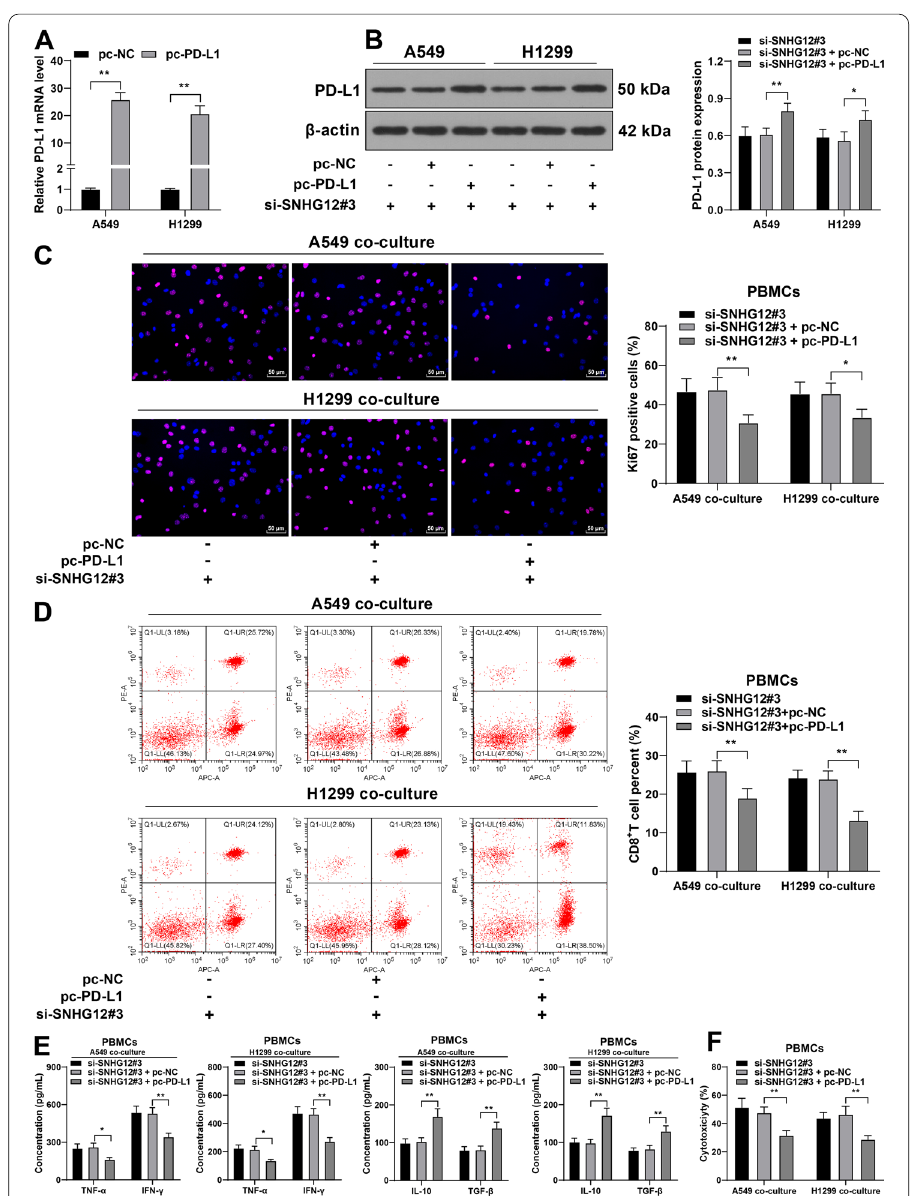
Fig. 8 PD-L1 overexpression attenuated the inhibition of silencing lncRNA SNHG12 on immune escape of NSCLC. A549 or H1299 cells were transfected with PD-L1 pcDNA3.1 (pc-PD-L1), with NC pcDNA3.1 (pc-NC) as the negative control. A , B PD-L1 expression in NSCLCs was measured via RT-qPCR and western blotting; A549 or H1299 cells in different treatment groups were co-cultured with isolated PBMCs. C PBMC proliferation was observed via Ki67 staining; D percentage of CD8 + T cells in PBMCs was detected via flow cytometry; E concentrations of TNF-α, IFN-γ, IL-10, and TGF-β were determined via ELISA; F cytotoxicity of PBMCs was detected via LDH cytotoxicity assay. Cell experiments were performed three times, * P < 0.05, ** P < 0.01. Data are represented as mean standard deviation. Multigroup comparisons in A – F were analyzed using two-way ± ANOVA, followed by Tukey’s multiple comparison